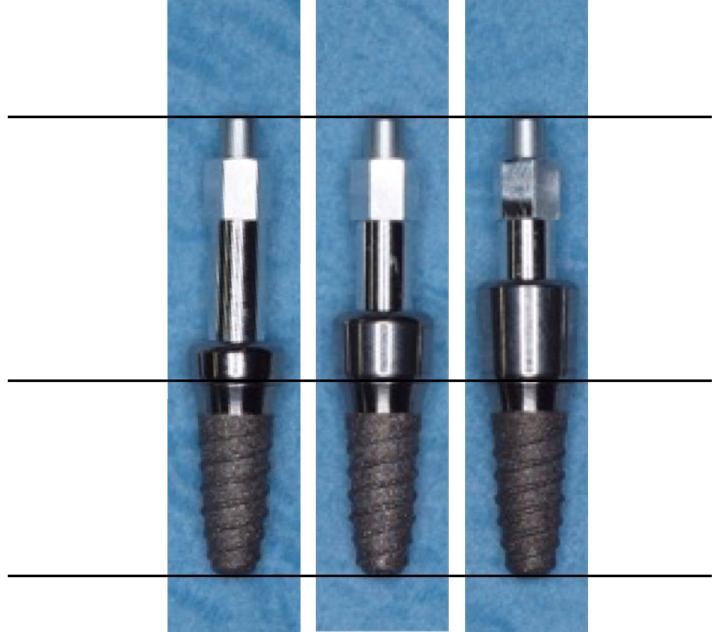
Figure 5. Healing plugs of different heights (2/3.5/5 mm) placed on the implant; it can be seen that the total height of the SmartPeg is the same (distance to the bone/implant shoulder) so as not to distort the resonance frequency analysis (RFA).